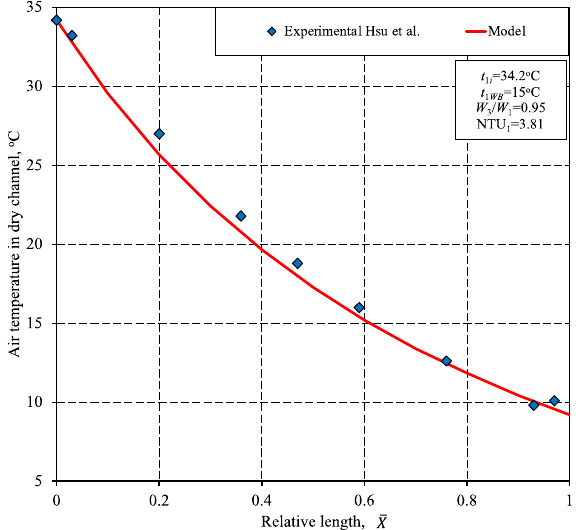
Figure A1. Product air temperature along the dry channel obtained from simulation and experimental data of Hsu [23].